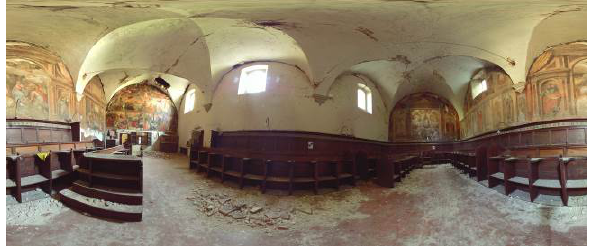
Figure 2. Overview of the choir of the Beata Antonia’s monastery, shot using a Leica C10 laser scanner.